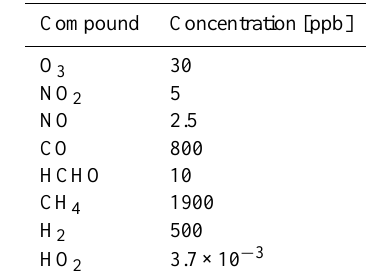
Table 3. Input concentrations [ppb] to the chemical mechanism based on Boy and Kulmala (2002) and typical spring values mea- sured in Southern Indiana by the Indiana Department of Environ- mental